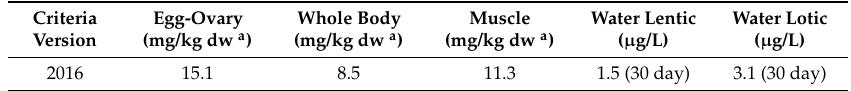
Table 1. US Environmental Protection Agency (EPA) 2016 Aquatic life criteria for selenium.